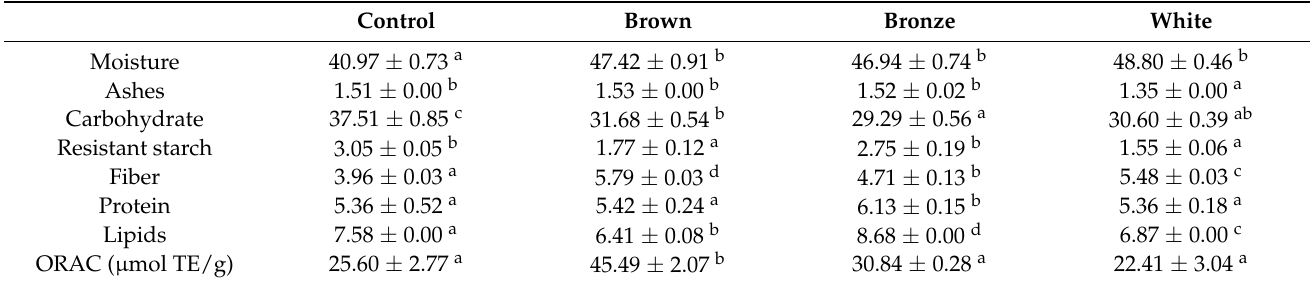
Table 1. Chemical composition (g/100 g) and antioxidant activity of control and sorghum bread. Control Brown Bronze White Moisture